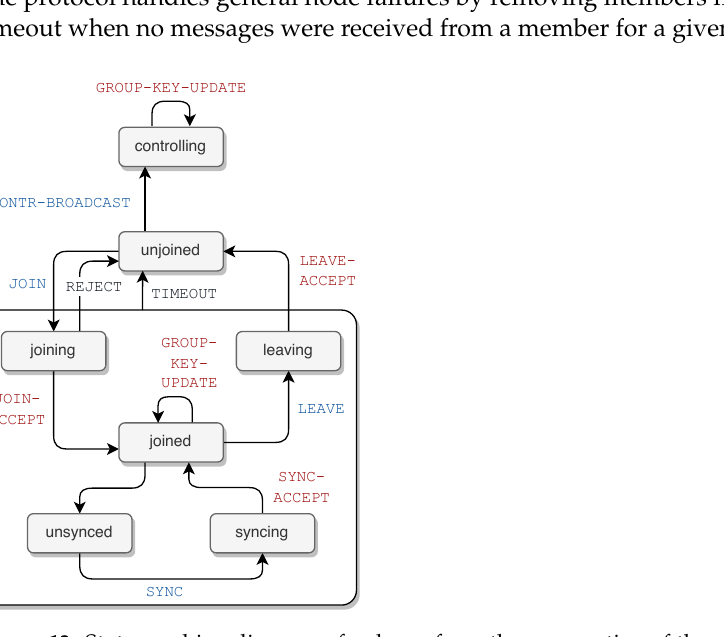
Figure 13. State machine diagram of a drone from the perspective of the group’s controller. State changes occur through messages sent by the member (blue) and controller (red) or